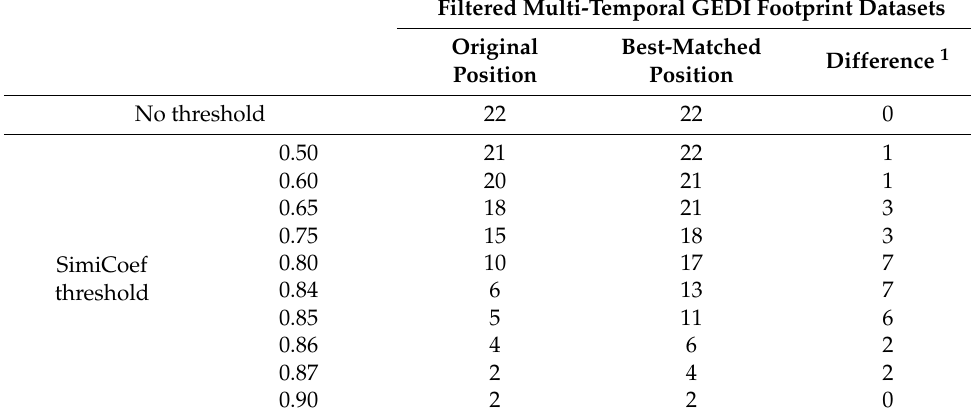
Table 6. The different thresholds of waveform similarity coefficient (R) and the number of temporal GEDI footprint datasets that meet the threshold.